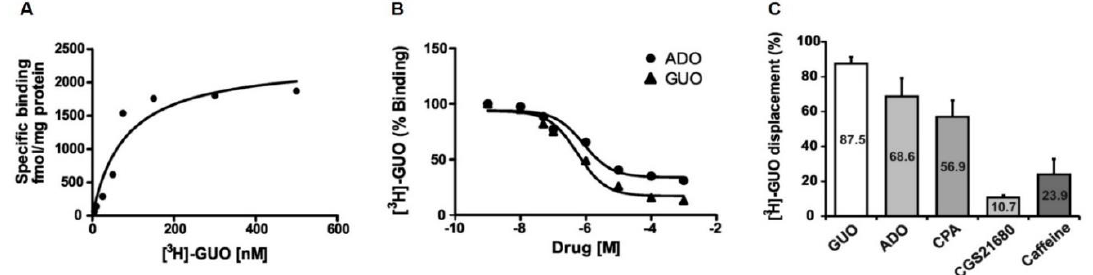
Figure 4. Anxiolytic-like e ff ect of GUO evaluated by light–dark box (LDB) and open field test (OFT) test during a 5 min session. ( A , B ) The LDB data analysis revealed that GUO treatment (30 mg / kg) significantly increased the time spent in light box, as compared to control (Ctrl) group, whereas the number of entries although increased did not become significant. This anxiolytic-like e ff ect of GUO treatment was completely blocked by pretreatment with nonselective ARs agonist ADO. ADO treatment alone did not a ff ect behavior as compared to control group. ( C , D ) The OFT data analysis revealed that GUO treatment (30 mg / kg) significantly increased both the number of central transitions and the amount of time spent in the center of the arena compared to control group. This anxiolytic-like e ff ect of GUO was completely blocked by pretreatment with ADO, and ADO treatment alone did not a ff ect behavior as compared to control group. LDB: time in light [F (3,41) = 6.146, p < 0.002], number of entries [F (3,41) = 1.843]. OFT: time in center [F (3,42) = 4.330, p < 0.01], number of central transitions [F (3,42) = 9.930, p < 0.0001]. Each bar represents the mean value ± SD. Tukey test: * p < 0.05, ** p < 0.005, *** p < 0.0005. Ctrl raw mean values: ( A) 26.69 s; ( B ) 2.29; ( C ) 24.29 s; ( D ) 8.86.